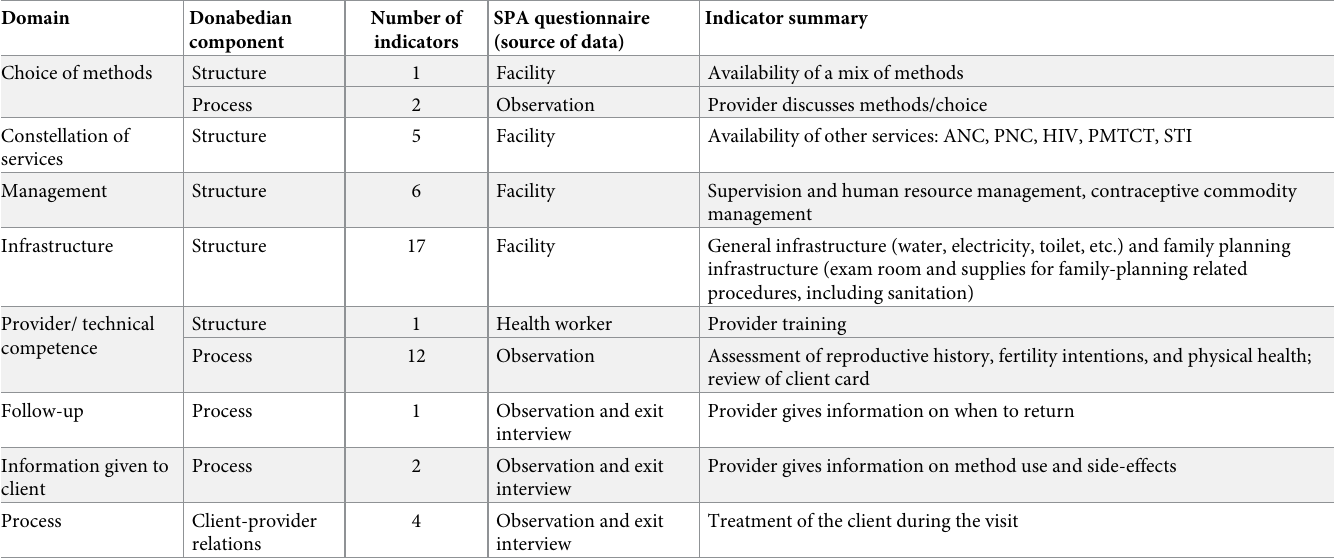
Table 1. Summary of domains and indicators used to create indices of quality of care